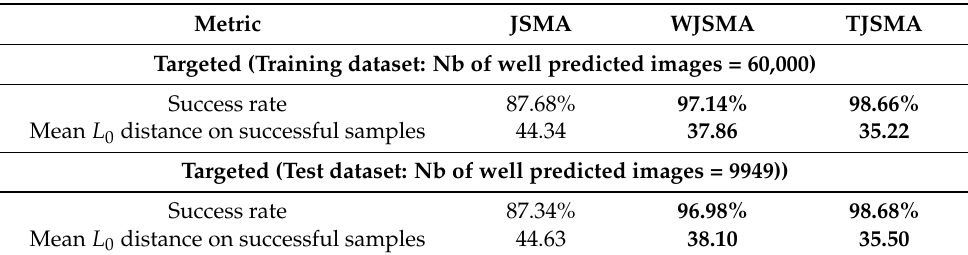
Table 1. Comparison between JSMA, WJSMA and TJSMA on MNIST.